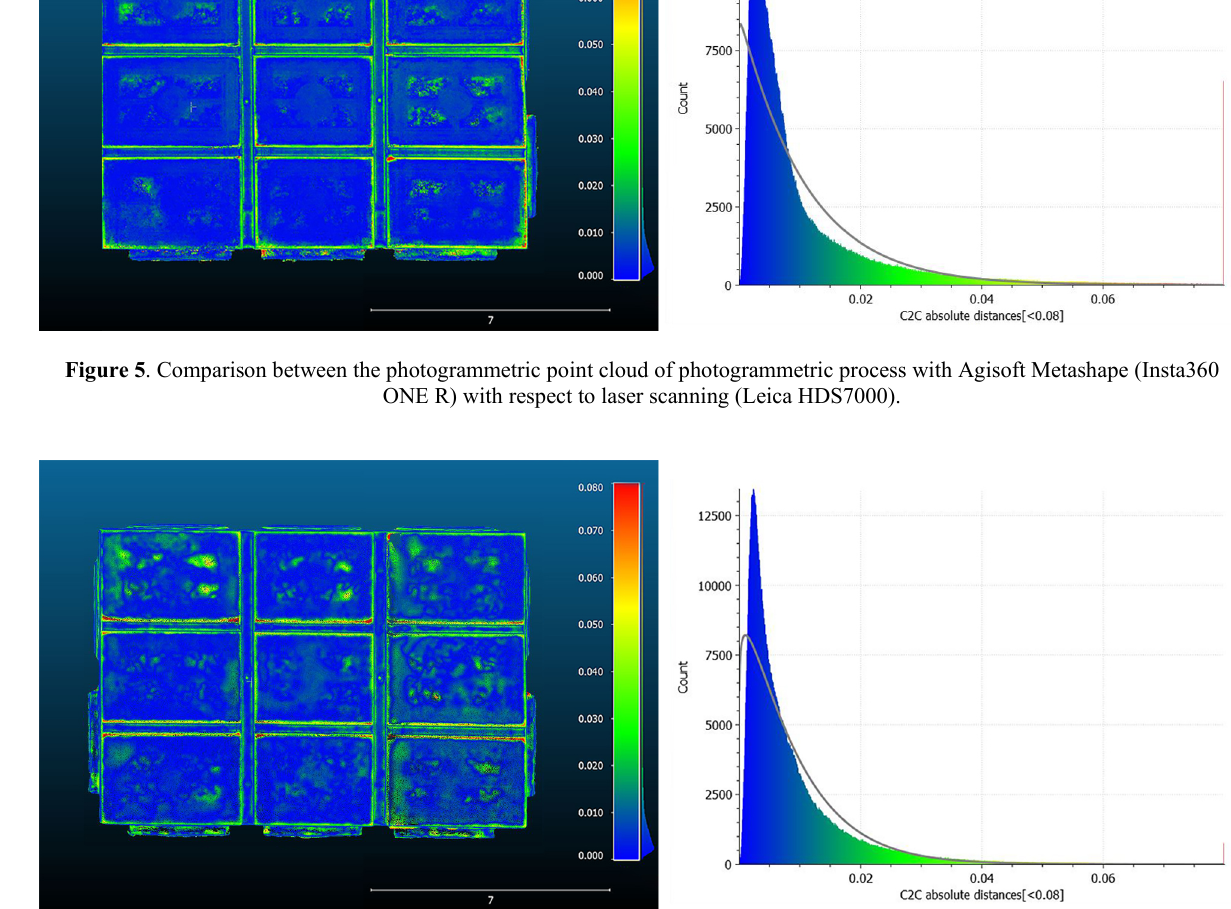
Figure 6 . Comparison between the photogrammetric point cloud of photogrammetric process with eyesCloud3d (Insta360 ONE R) with respect to laser scanning (Leica